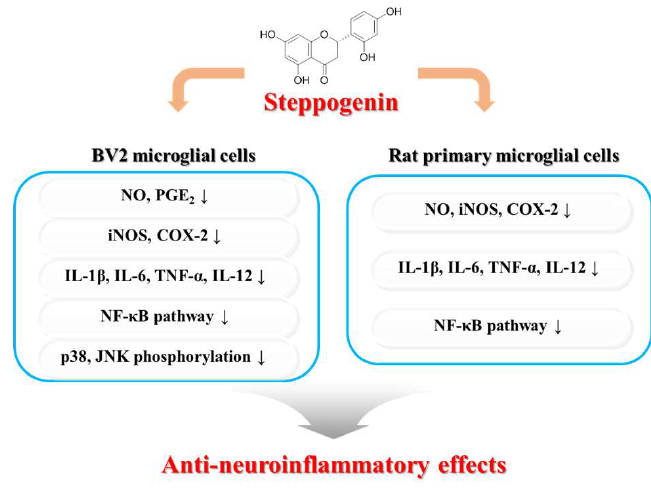
Figure 10. Schematic diagram showing the relationship of steppogenin ( 1 ) and NF-κB/inflammation/MAPK damage after LPS in BV2 microglial and rat primary microglial cells.